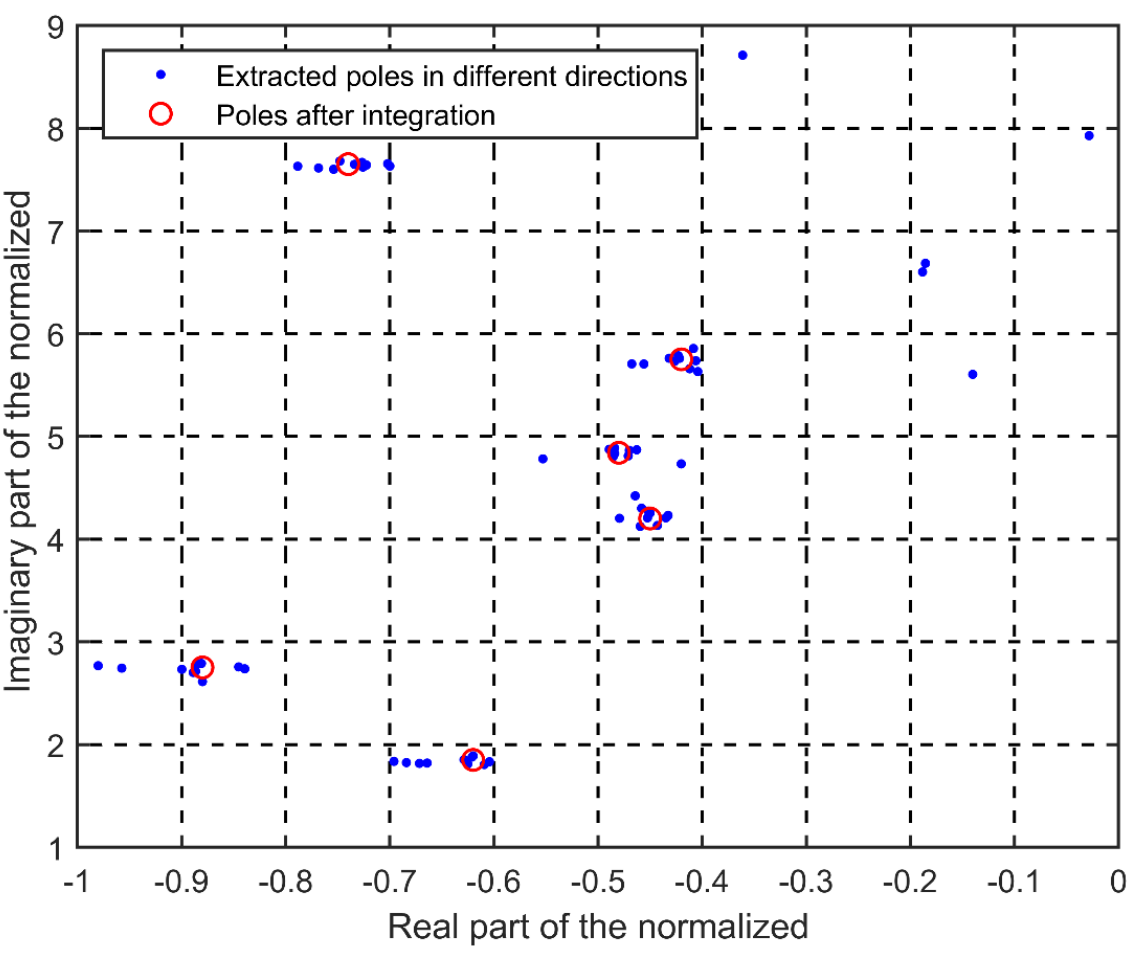
Figure 4. Extracted poles distribution of the matrix beam method. The blue marks are the original poles extracted in ten directions and the red marks are the poles obtained after correction.